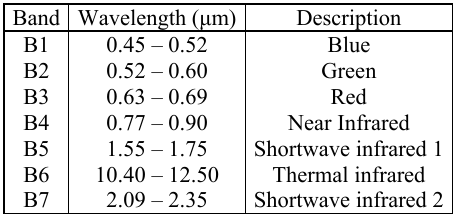
Table 1. Spectral bands of the Landsat 5 imagery (Gašparović et